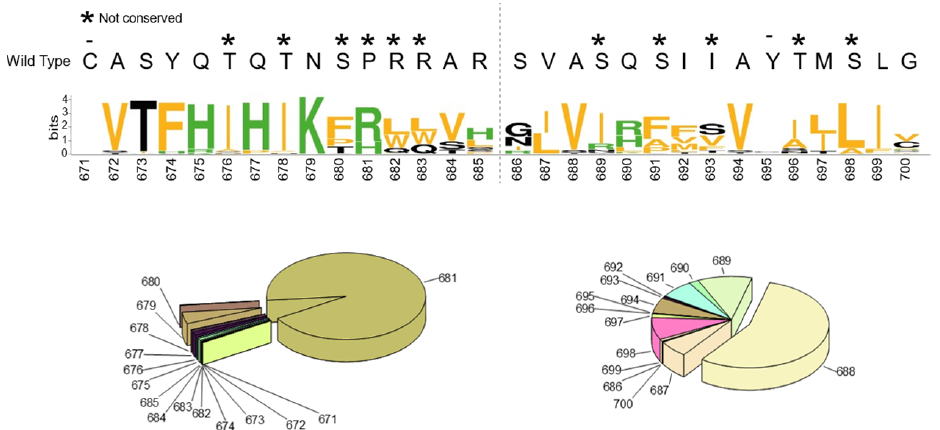
Figure 4. (Top) Sequence logo relative to the spike SARS-CoV-2 S shows the most popular naturally occurrent amino acid replacement for each position, taken individually (https://weblogo.berkeley.edu/logo.cgi, 30 August 2022); (Bottom) Statistic cake images reporting the relative contribution of the sum of all mutant sequences at a given position, grouped according to P (left) and (P’) residues. C671 was no match for any other amino acid, underlying its prominent function. In fact, Cys at 671 is engaged in a disulfide bridge with Cys 662 and it is crucial for the overall architecture of the spike protein [49]. Similarly, Tyr 695 is also invariable, probably due to the very favorable T-shaped p stacking interaction established with the side chain of the aromatic Tyr 660, stabilizing the protein structure. Actually, Tyr 695 and Tyr 660, together with Ile 693 and Val 656, form a singular highly hydrophobic pocket (Figure